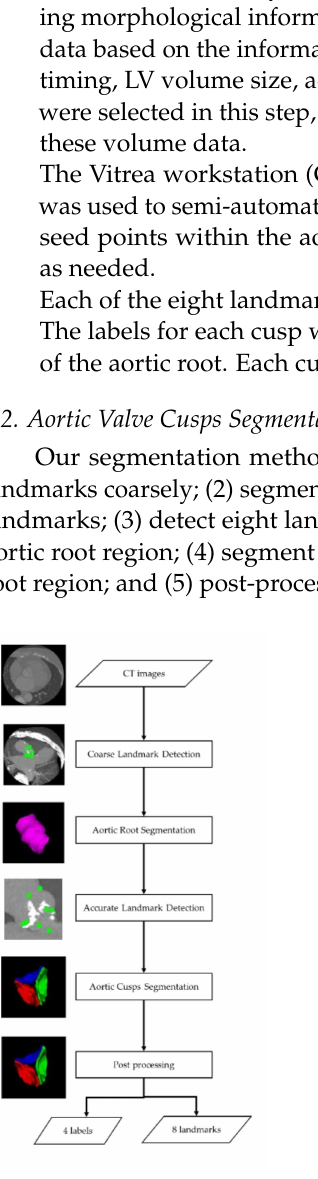
Figure 1. Flow chart of segmentation